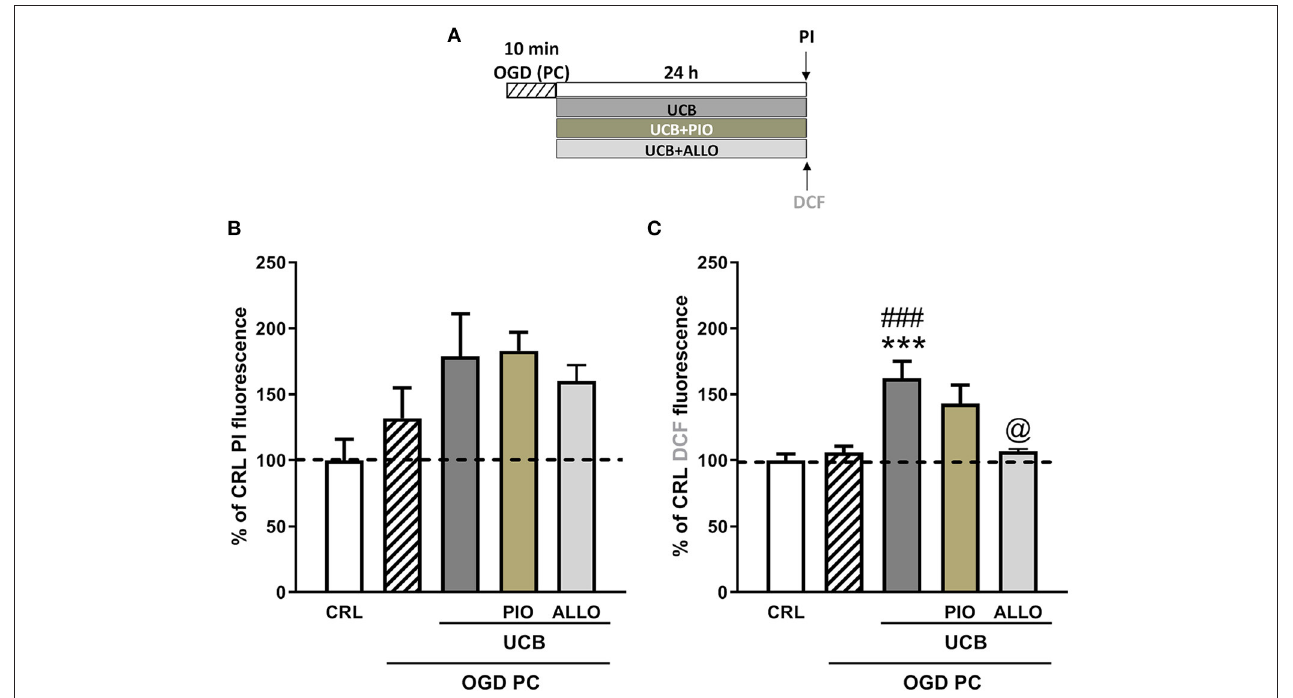
FIGURE 6 | Effects of pioglitazone and allopurinol on unconjugated bilirubin (UCB) induced-toxicity in OGD preconditioned immature organotypic hippocampal slices. (A) Experimental protocol showing immature hippocampal slices exposed to OGD preconditioning and then to UCB (100 µ M) for 24h alone or plus pioglitazone (10 µ M) or allopurinol (10 µ M). Quantitative analysis shows that OGD-preconditioning, UCB, pioglitazone, and allopurinol did not affect cellular death in immature slices (B) , while UCB increases cellular oxidative stress that is reduced by allopurinol but not pioglitazone (C) . Quantitative analysis: Bars represent the mean ± SEM of at least seven experiments (about ≥ 28 slices for each experimental point). *** P < 0.001 vs. CRL; ### P < 0.001 vs. OGD preconditioning; @ P < 0.05 vs. UCB.